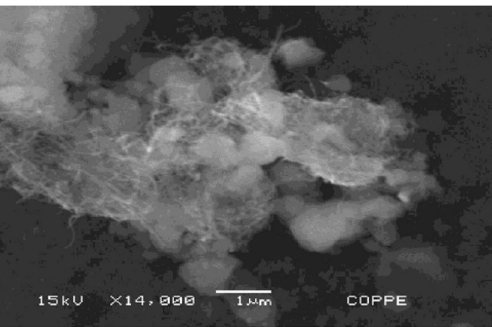
Figure 1. SEM image of MgH2 milled with 5 wt% MWCNT for 20 min